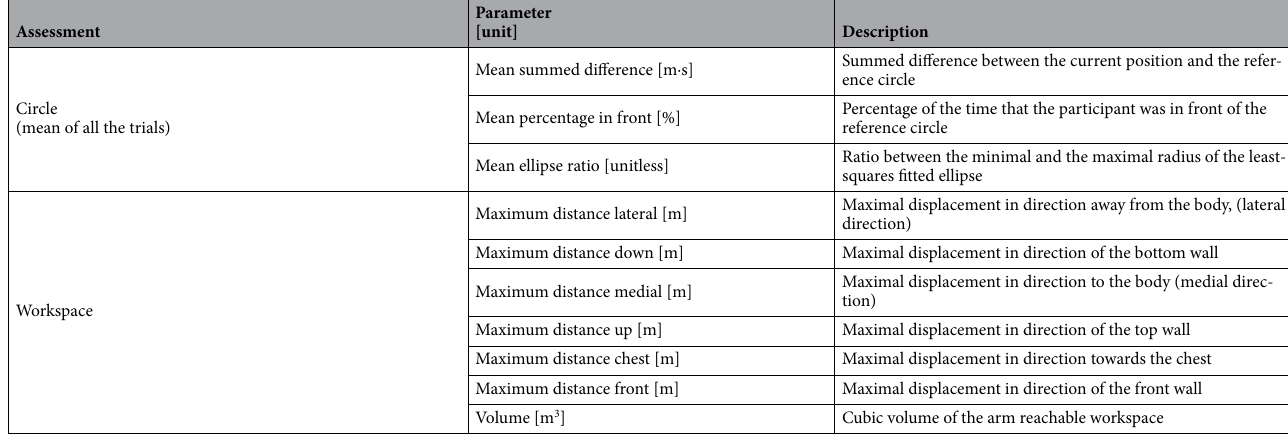
For each parameter, we calculated the average of the three trials. (f) During ‘Circle’, the child was asked to follow as accurately as possible a green ball making a circular move- ment on the screen. The child was instructed to position a red ball (reflecting the wrist position) as precisely as possible on the green ball and follow its circular movement by moving the arm accordingly with the attached exoskeleton. Movement quality was reflected by two parameters: The mean summed difference [m·s] is the integrated difference between the red and the green ball averaged over the executed rounds and the mean ellipse ration [unitless] is the quotient between the smaller and the larger radius of an ellipse fitted to the performed circle on screen., Additionally we calculated a temporal parameter: The mean percentage in front [%] which indicates the percentage in which the red ball from the patient was in front of the green